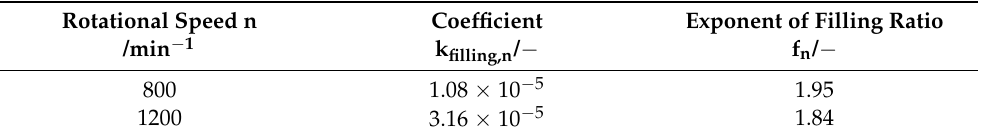
Table 10. Variables for model equation (Equation (17)) to describe the normal stressing energy based on the filling ratio ϕ media ( − ) for d media = 10 mm.